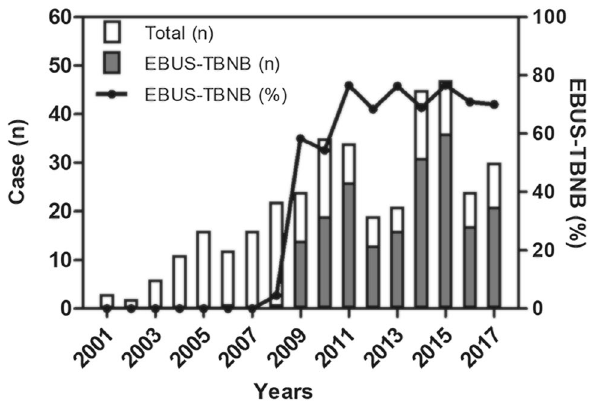
Figure 1. Annual number of patients diagnosed with sarcoidosis in 2001–2017. The white bars represent total patients, and the black bars represent patients diagnosed by EBUS-TBNB. The black lines with dots represent the proportion of patients diagnosed with EBUS-TBNB. EBUS-TBNB, endobronchial ultrasound-guided transbronchial needle biopsy.